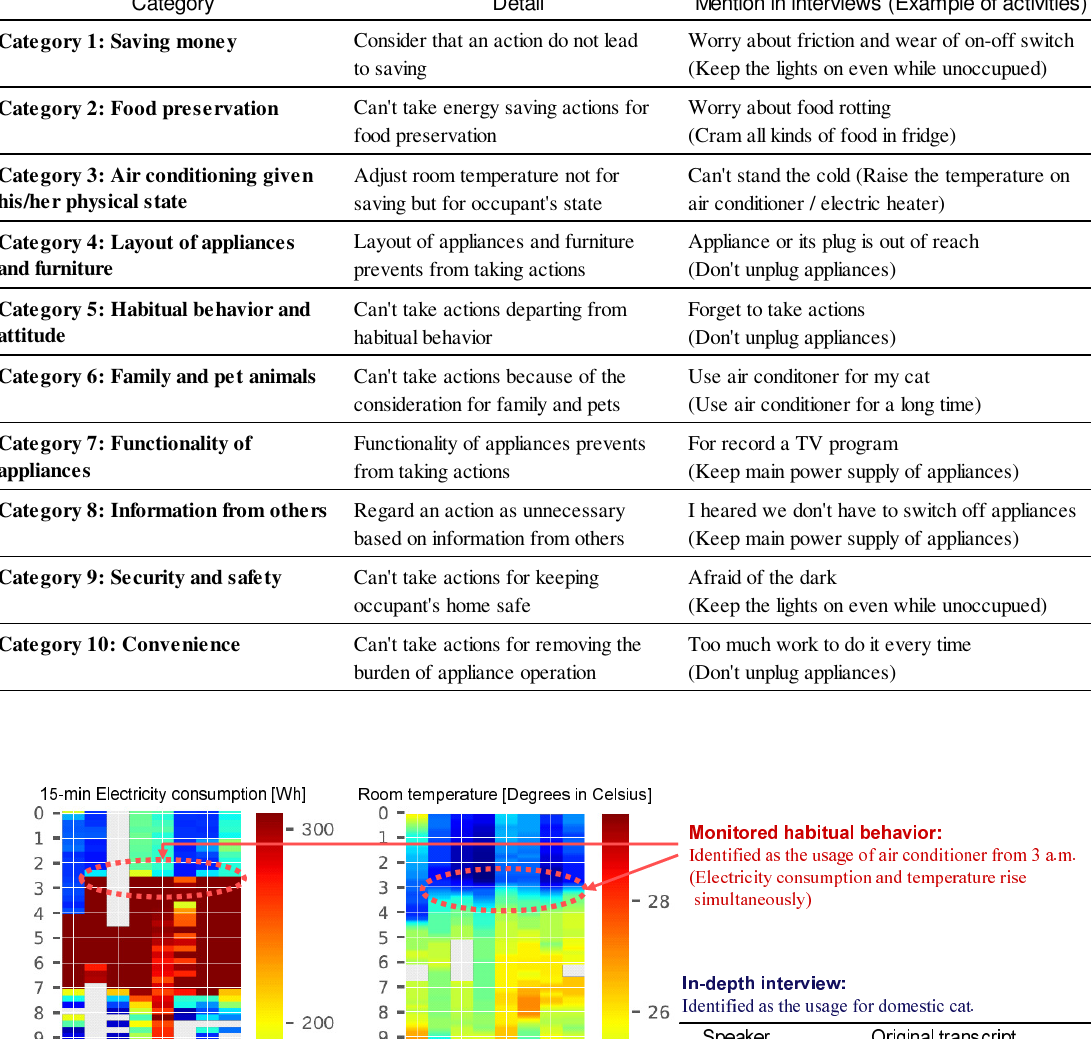
Table 2. Extracted and categorized barriers regarding energy saving activities. Detail Mention in interviews (Example of activities)